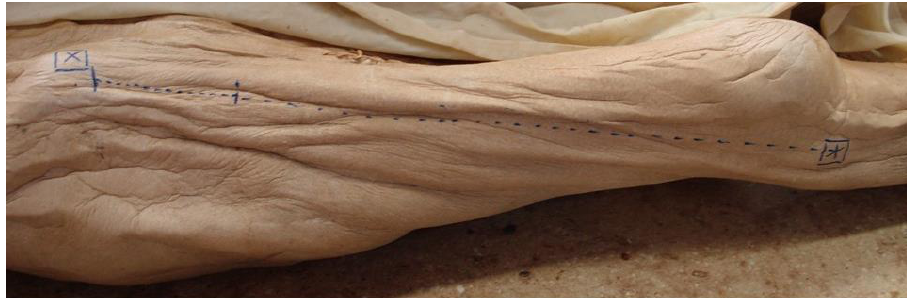
Figure 1. Axis for the orientation of the skin incision. X = ASIS * = caput fibulae.